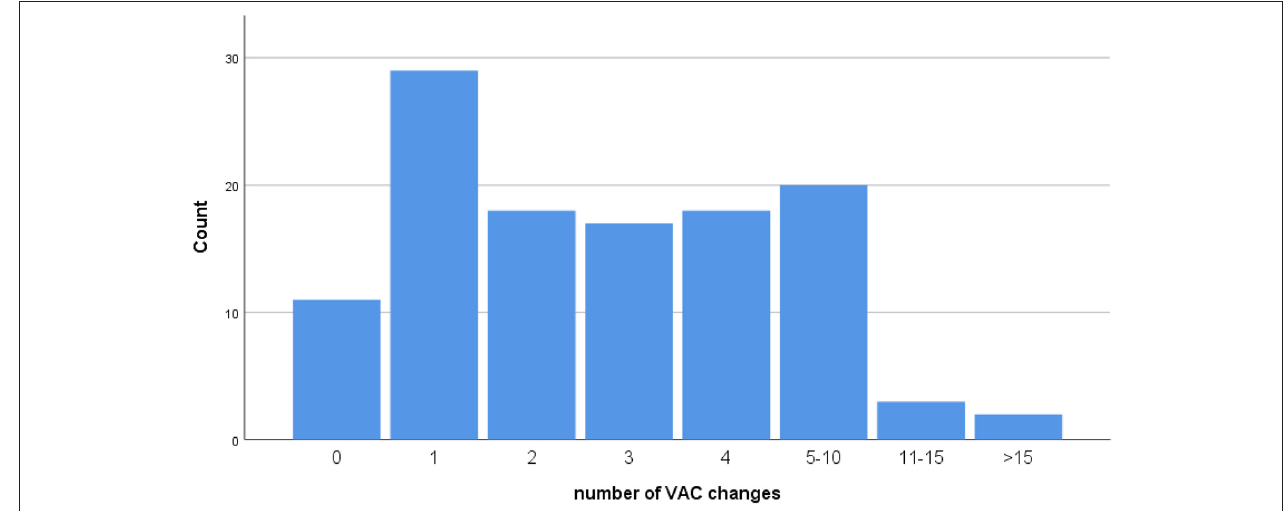
FIGURE 2 | Number of VAC changes classified according to EuraHS.